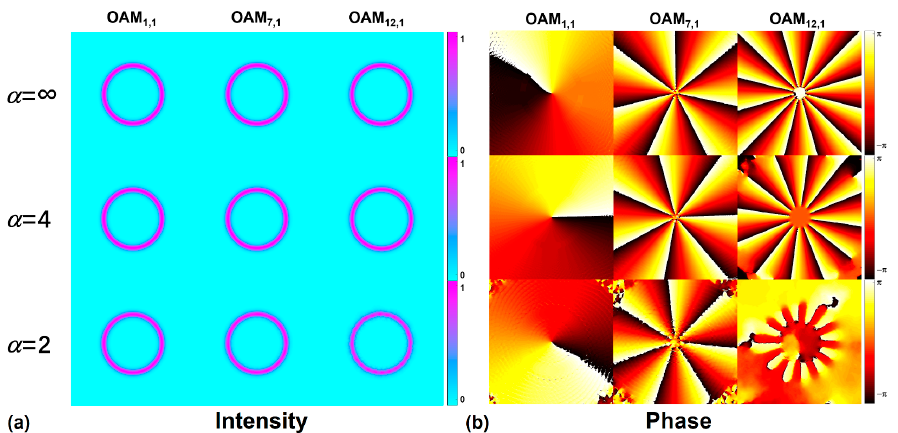
Figure 2. ( a ) Intensity and ( b ) phase distributions of the OAM 1,1 , OAM 7,1 , and OAM 12,1 modes in the RCF with α = 2, 4, ∞ , respectively.